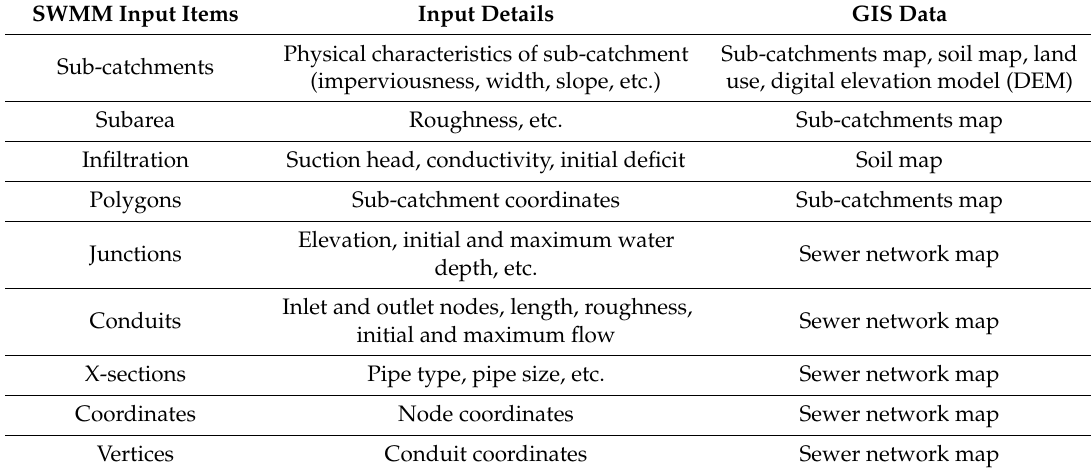
Table 2. Description of Storm Water Management Model (SWMM) inputs and Geographical Information System (GIS)